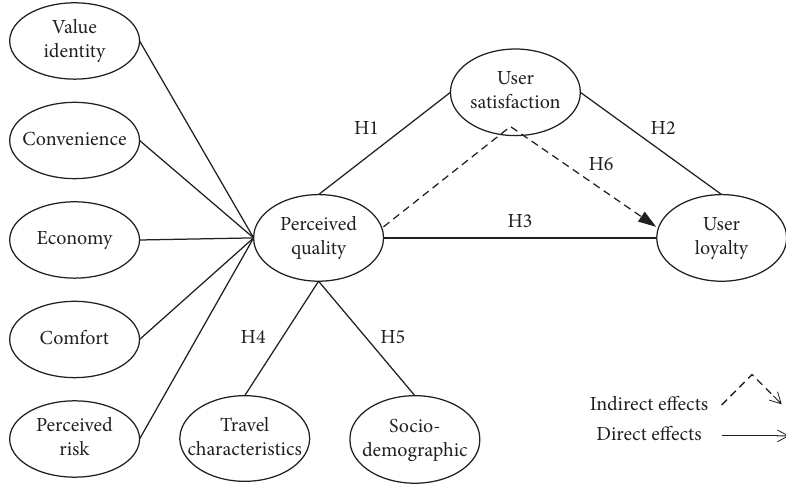
Figure 1: Conceptual model of shared bike selection behavior. Table 1: Demographic